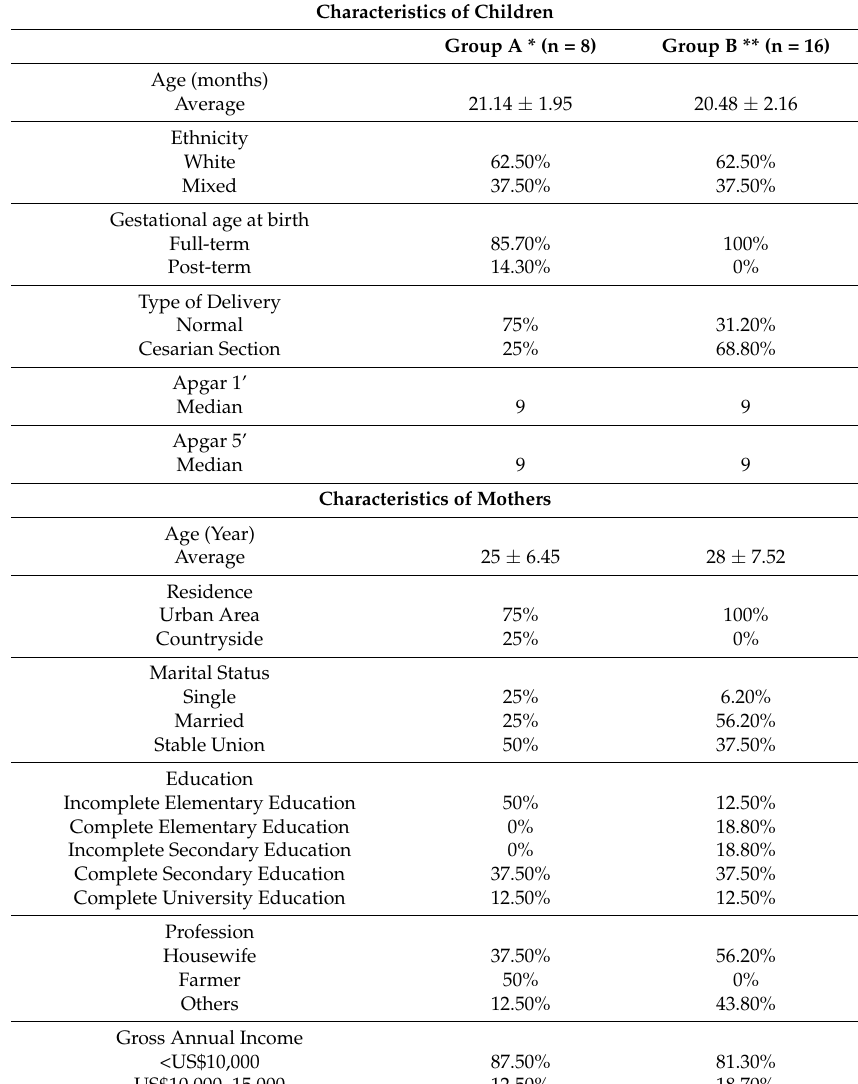
Table 1. Average, Standard Deviation, and percentage distribution by categories in relation to sociodemographic/clinical variables of the children and sociodemographics of the mothers studied (n = 8 group A; n = 16 group